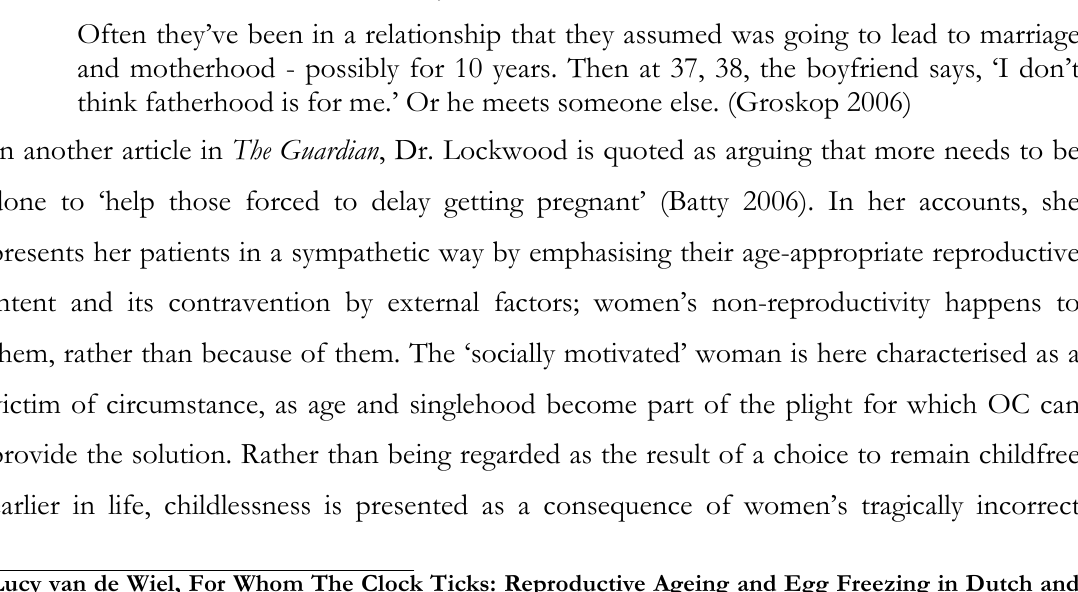
Lucy van de Wiel, For Whom The Clock Ticks: Reproductive Ageing and Egg Freezing in Dutch and British News Media Studies in the Maternal , 6(1), 2014,